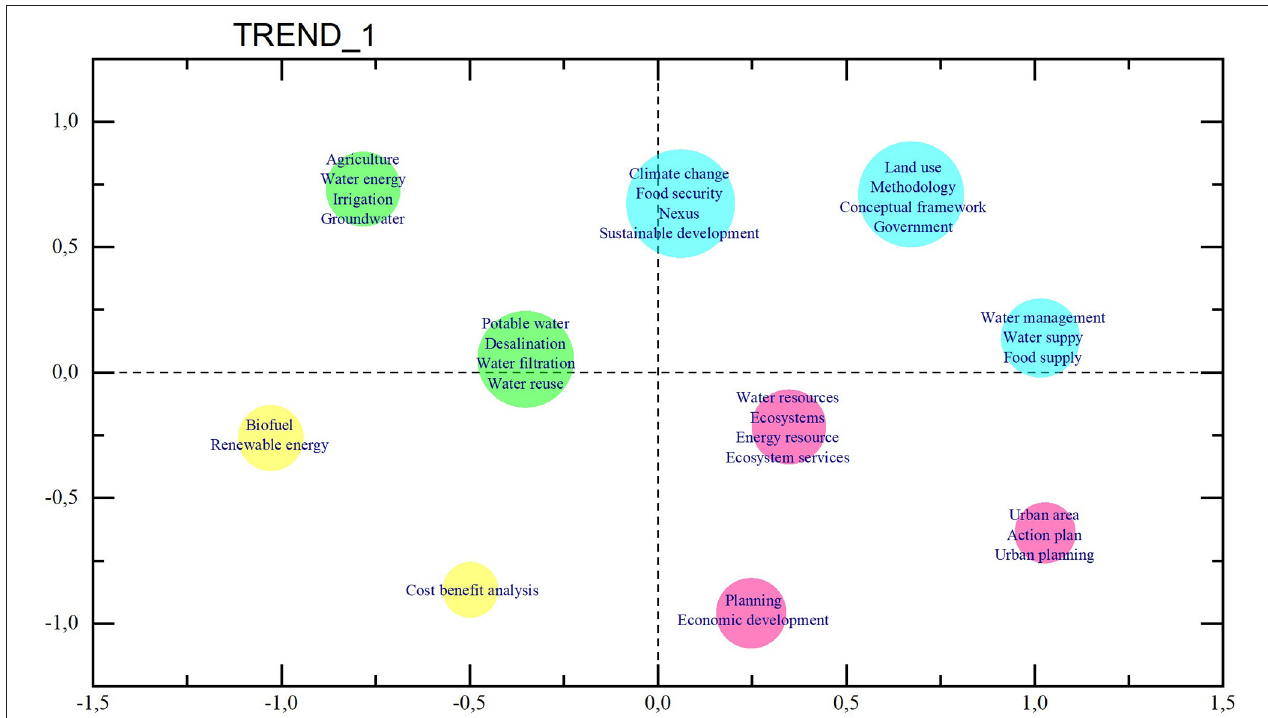
FIGURE 4 | Trend 1 key topics on the WEF nexus research in the period